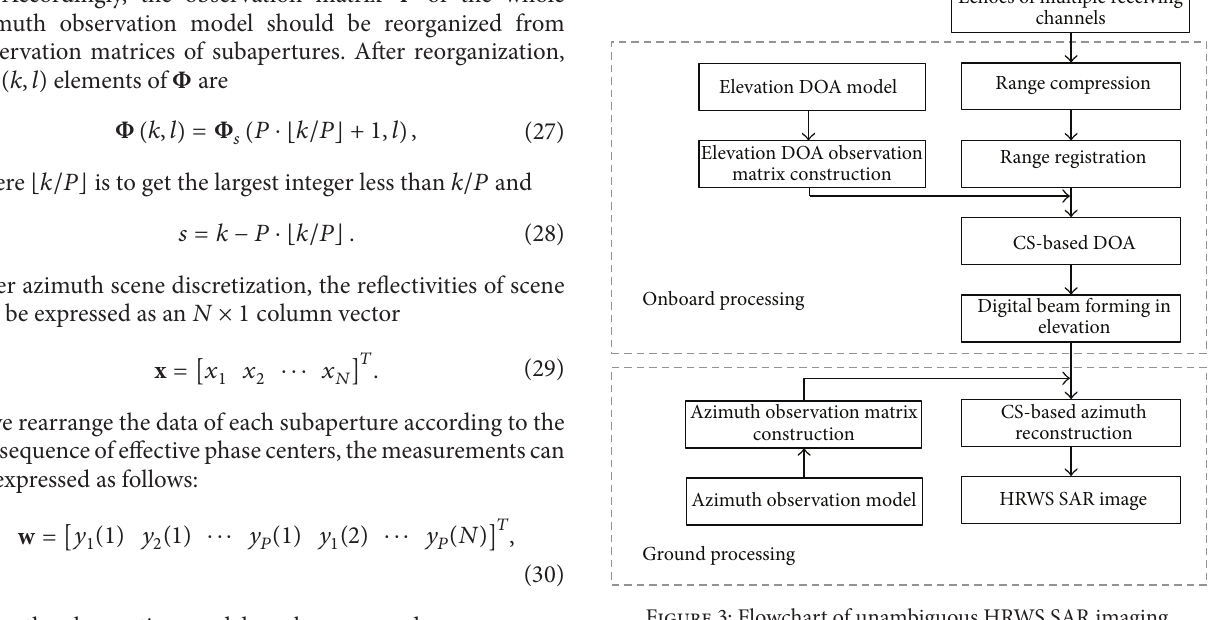
Figure 3: Flowchart of unambiguous HRWS SAR imaging.